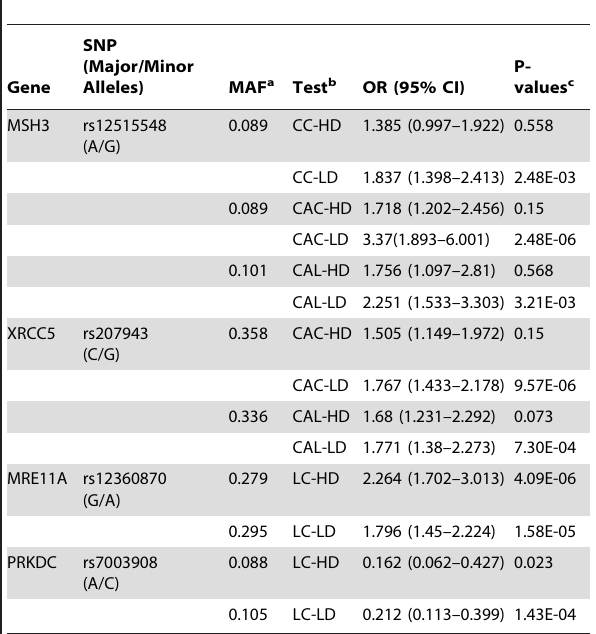
Table 4. Allelic associations in with respect to tobacco